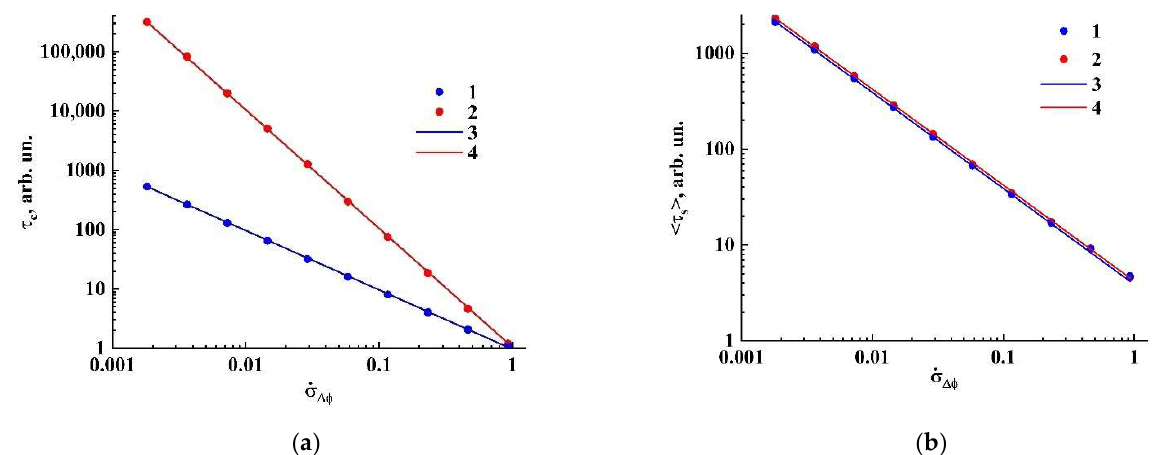
Figure 6. ( a ) Model values of the speckle correlation time against the root mean square of phase shifts per unit simulation step (1, 2) and the corresponding fitting dependencies (3, 4); ( b ) the same for the average speckle lifetimes. (1, 3)—an ensemble of phasors with “regular” phase dynamics; (2, 4)—an ensemble of phasors with stochastic phase dynamics.